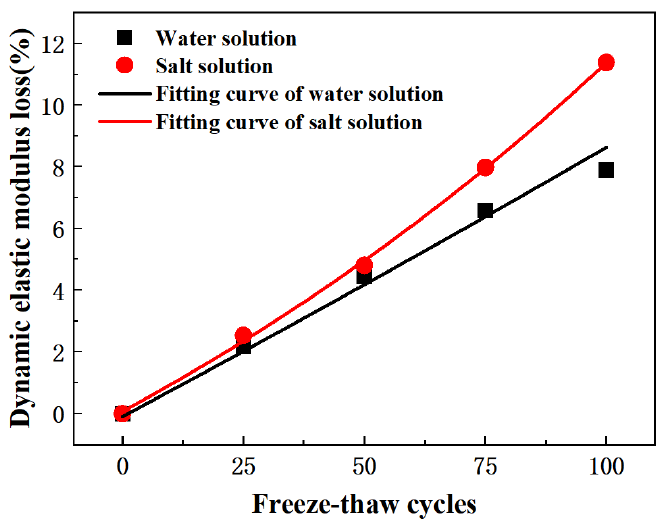
Figure 9. Fitting curve of dynamic elastic modulus loss of permeable concrete under freeze-thaw cycles.